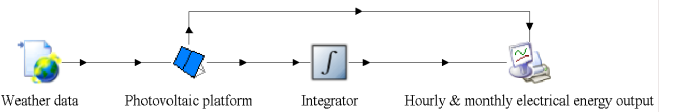
Figure 2. Trnsys17 model used for the evaluation of the photovoltaic platform energy output [27].